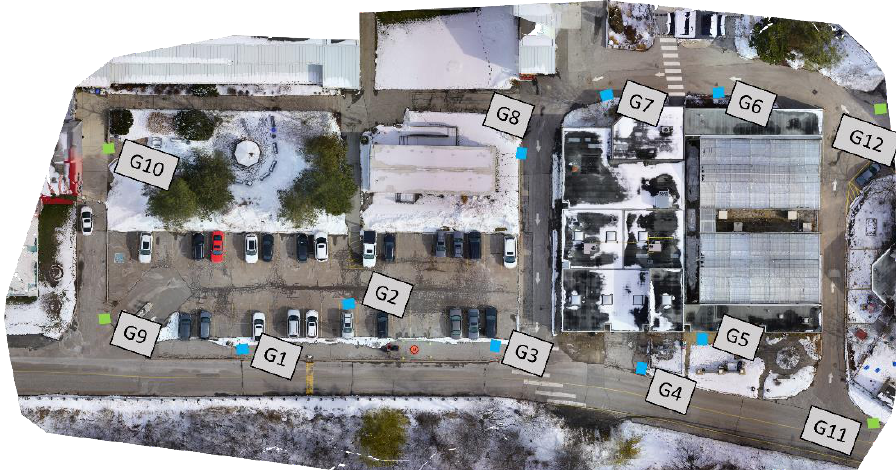
Figure 4. Ground control points (GCPs) and checkpoints distribution in study area.